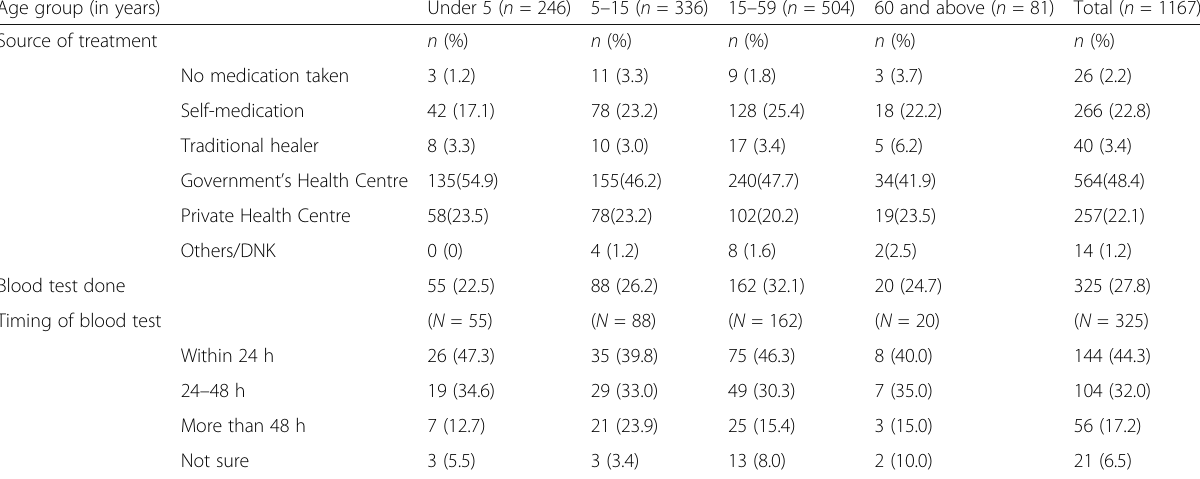
Table 2 Source of treatment and timing of blood test by age group among persons with undifferentiated fever within 2 weeks in the endemic regions of Myanmar in 2015 Age group (in